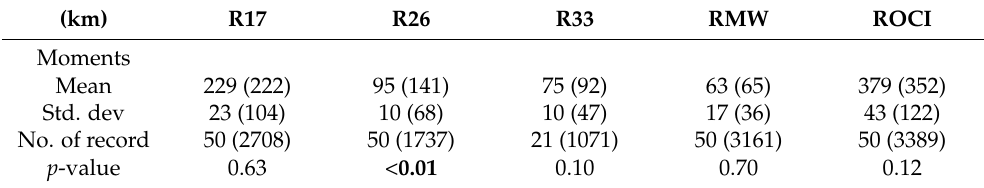
Figure 5. Three-hourly wind radii for critical wind speeds (R17, R26, R33, and RMW) and ROCI of all simulations for the 15-h period before landfall to landfall time. Table 2. Comparison of moments of the four TC size parameters (ROCI, R17, R26, R33, and RMW) among five simulations with climatology [52] with p -values from t-tests. Values from the previous study are in parentheses and the p -value < 0.05 is in bold